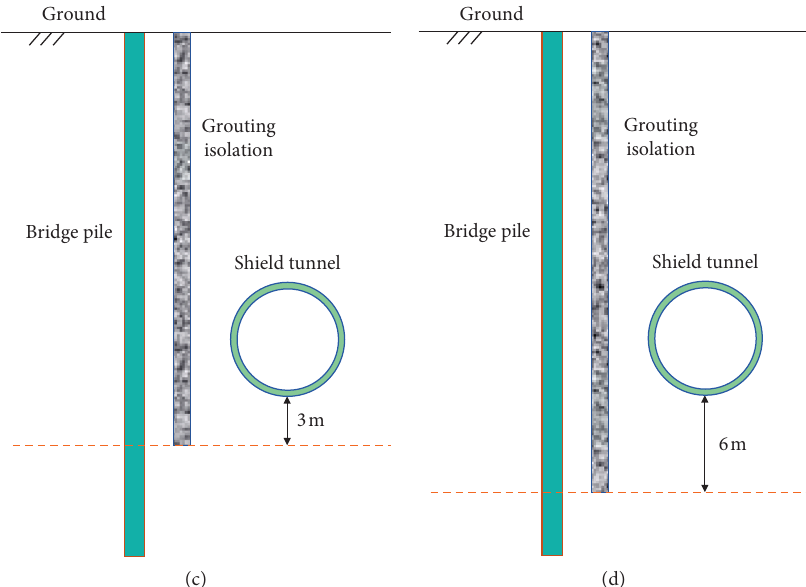
Figure 4: Grouting reinforcement scheme: (a) grouting to the top of the tunnel; (b) grouting to the bottom of the tunnel; (c) grouting to 3m below the bottom of the tunnel; (d) grouting to 6m below the bottom of the tunnel.